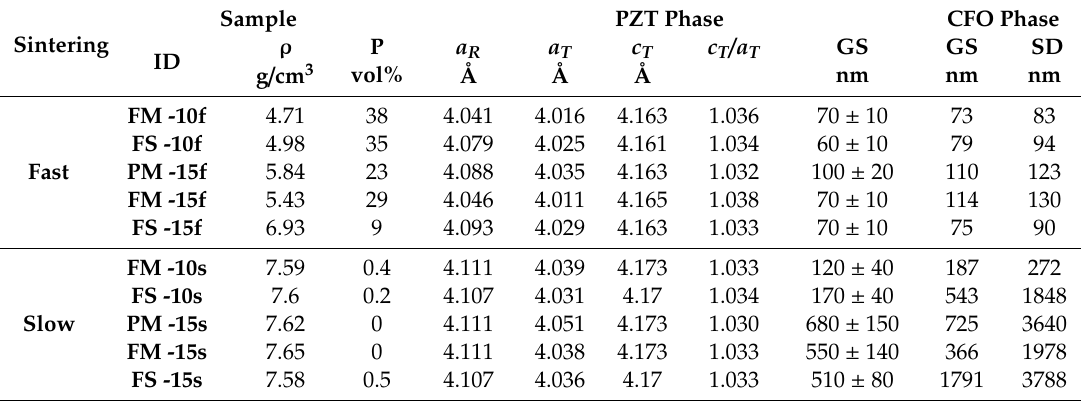
Table 1. Density ( ρ ), porosity (P), PbZr x Ti 1-x O 3 (PZT) lattice parameters: a R , a T , c T and c T / a T of rhombohedral and tetragonal perovskite (R and T, respectively), PZT and CoFe 2 O 4 (CFO) mean grain size (GS) and CFO Sauter’s diameter (SD). Sample acronym: P = partial reaction—calcination 850 ◦